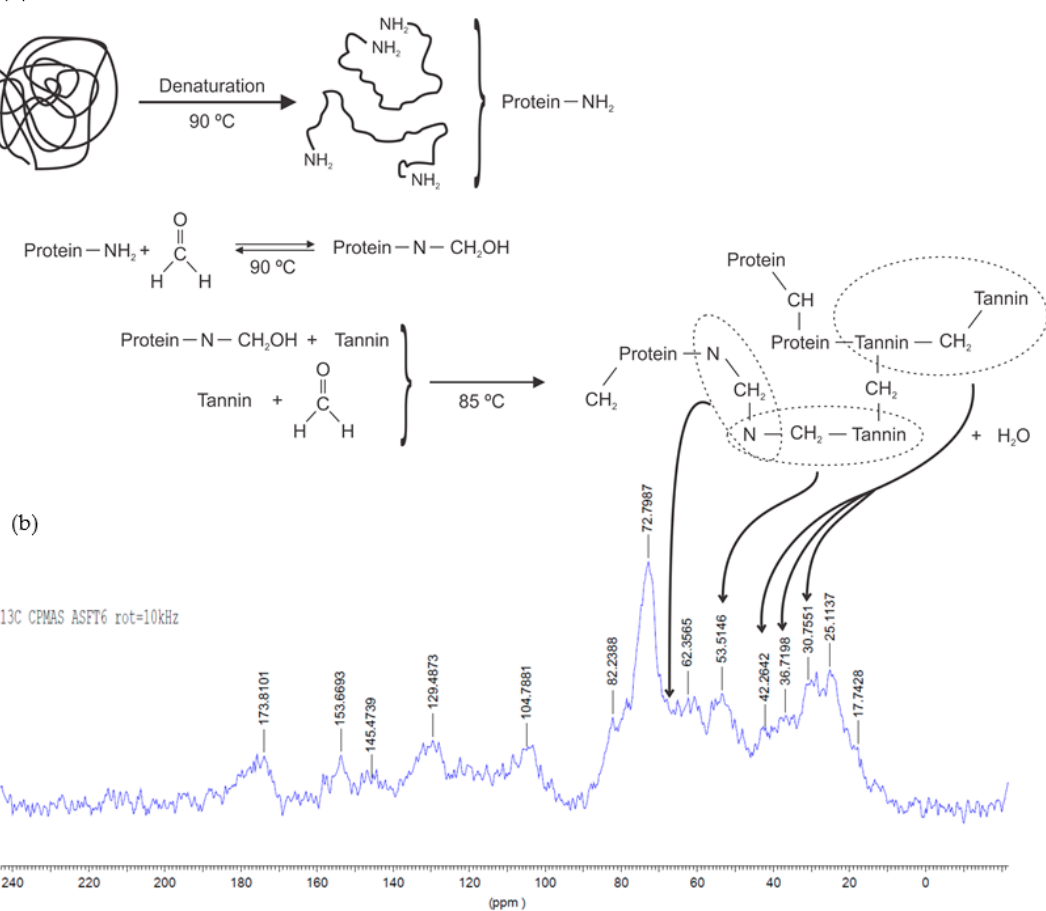
Figure 9. Suggested cross-linking reactions on tannin-soy-formaldehyde gel ( a ) and 13 C-NMR spectra of organic gel at pH 6 ( b ) [54].